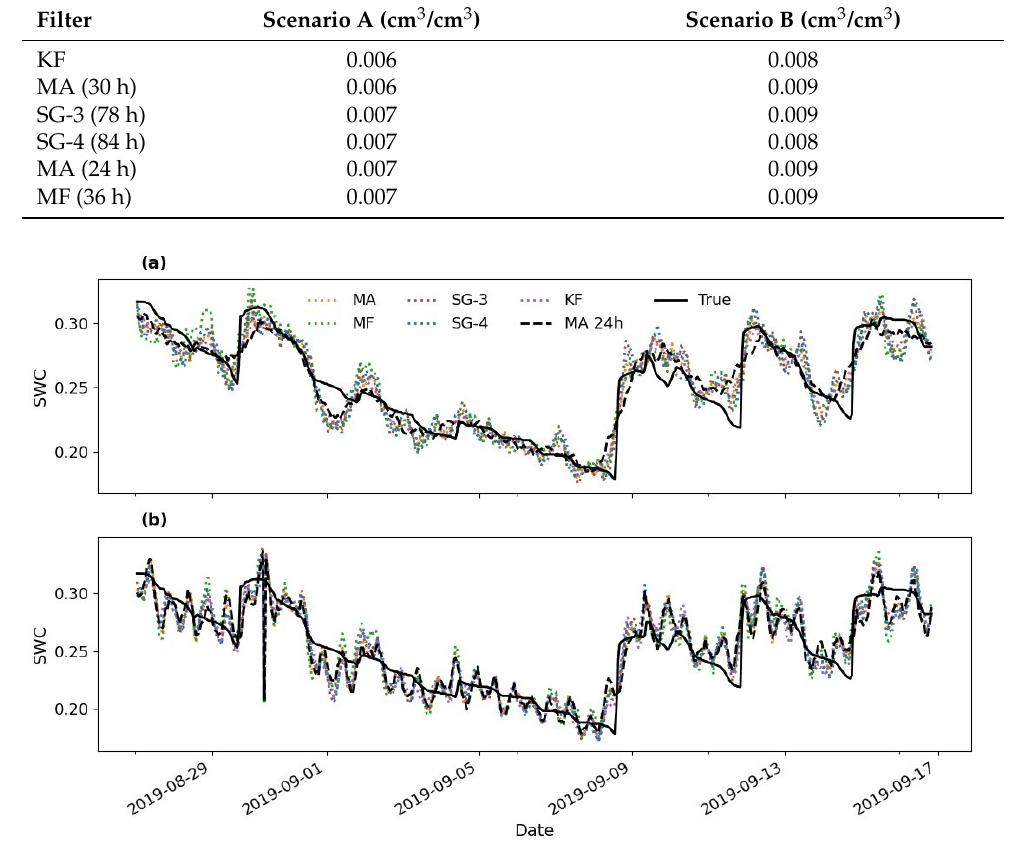
Figure 9. Time series of observed soil moisture (black line) at Gorigo and estimated soil water content from filtered synthetic neutron count based on two scenarios. Scenario A ( a ): Filters applied after atmospheric correction. Scenario B ( b ): Filters applied before atmospheric